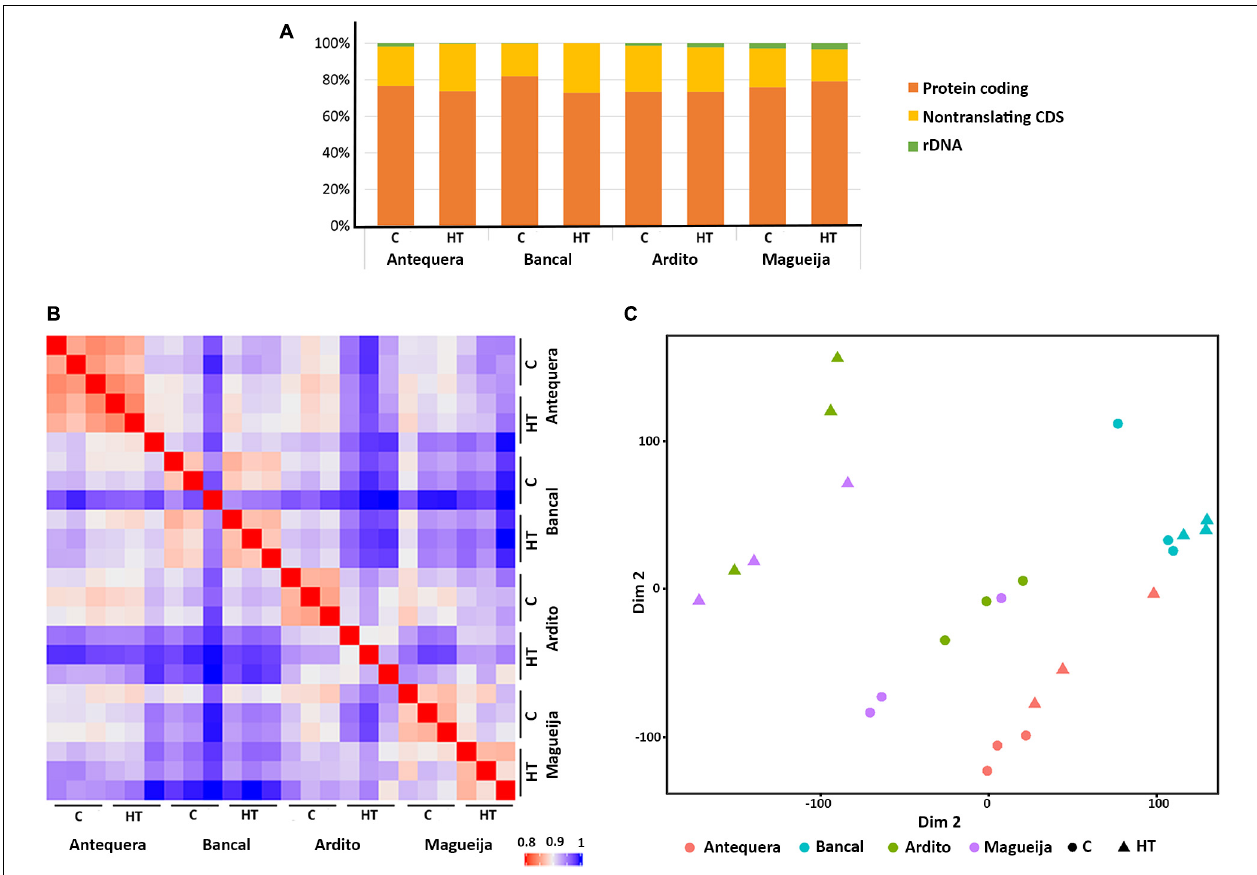
FIGURE 1 | Reads assignments by gene type and relationship between samples. (A) Read assignments and relative abundance of reads per type of gene. (B) Hierarchical clustering of sample-to-sample correlations based on Pearson correlations (right). (C) Multi-dimensional scaling (MDS) plot showing similarity between all samples. The comparisons were made between control (C) and high temperature (HT) reads sets of commercial varieties Antequera and Bancal and landraces Ardito and